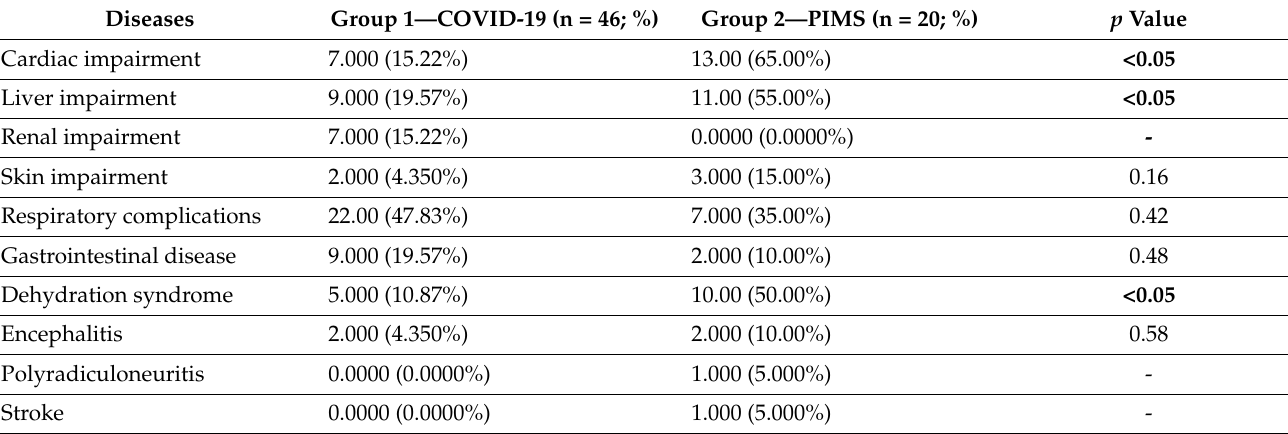
Table 7. Associated complications of the two